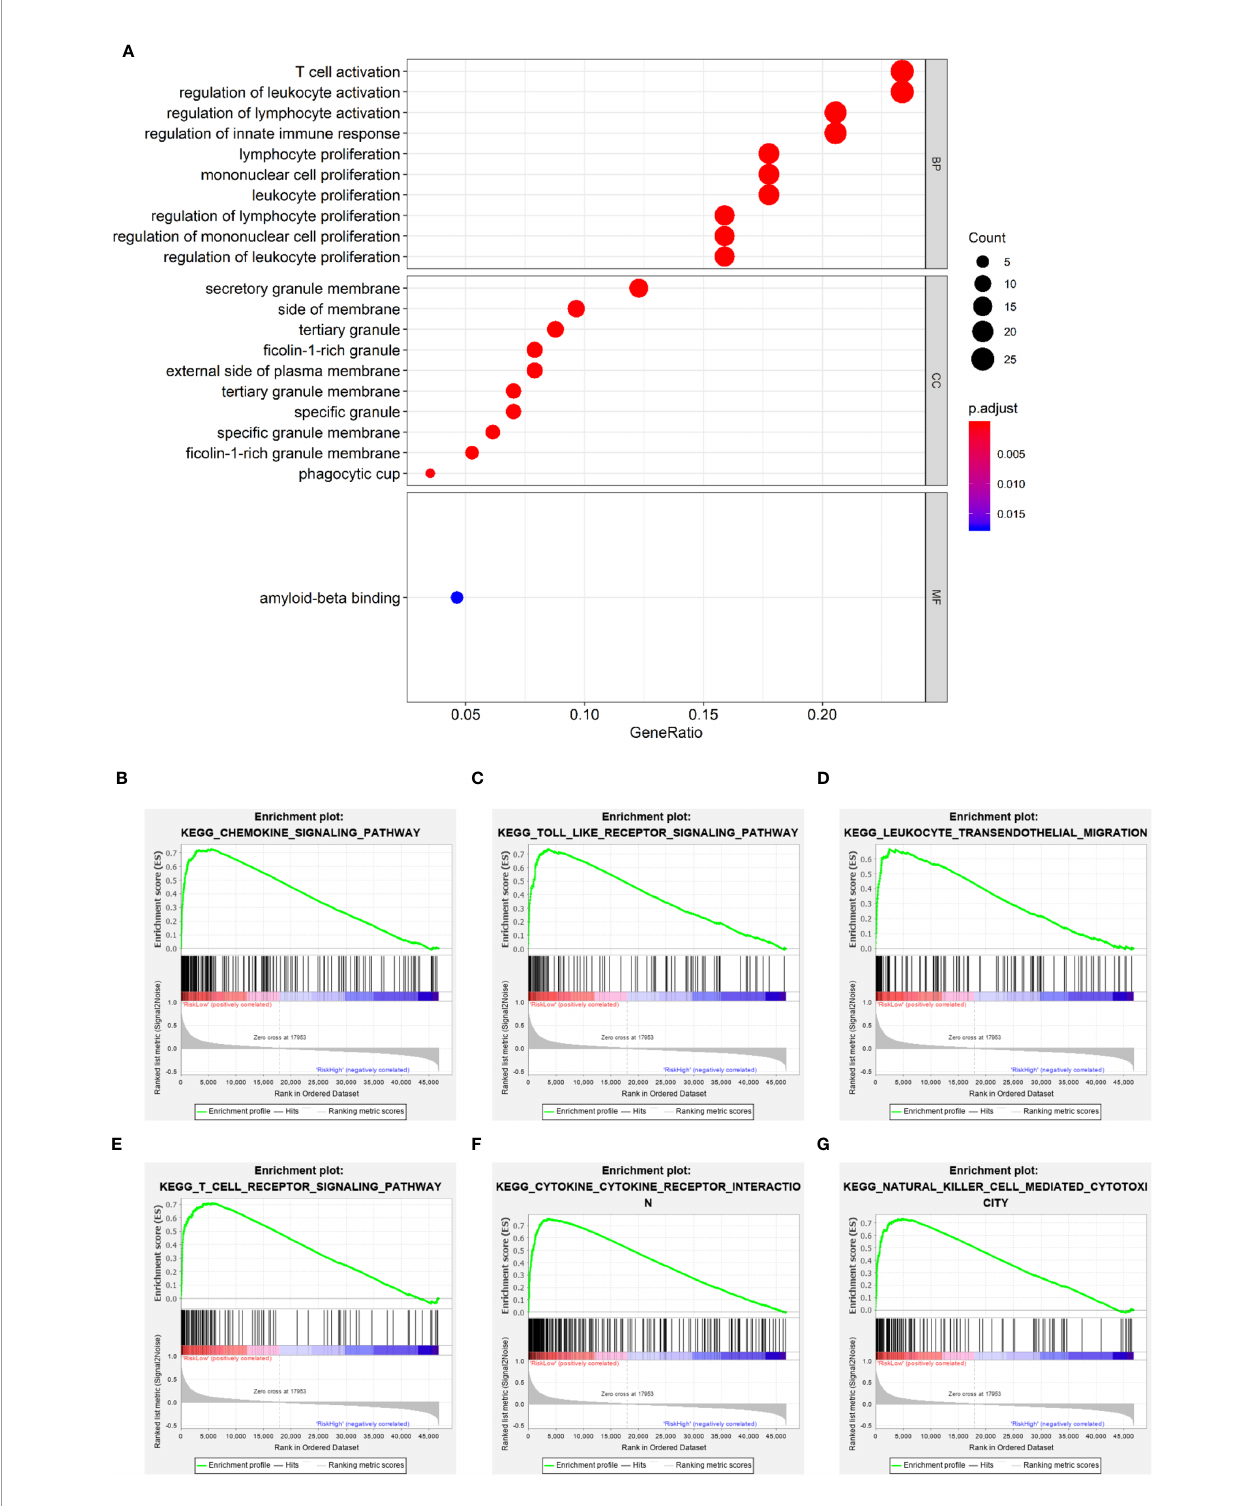
FIGURE 7 | Functional enrichment analyses. (A) Bubble graph for GO enrichment (the bigger bubble means the more genes enriched, and the increasing depth of red means the differences were more signi fi cant). (B – G) Representative enrichment plots generated by GSEA reveal that the low risk was signi fi cantly associated with chemokine signaling pathway (B) , Toll-like receptor signaling pathway (C) , leukocyte transendothelial migration (D) , T cell receptor signaling pathway (E) , cytokine- cytokine receptor interaction (F) , NK cell-mediated cytotoxicity (G)